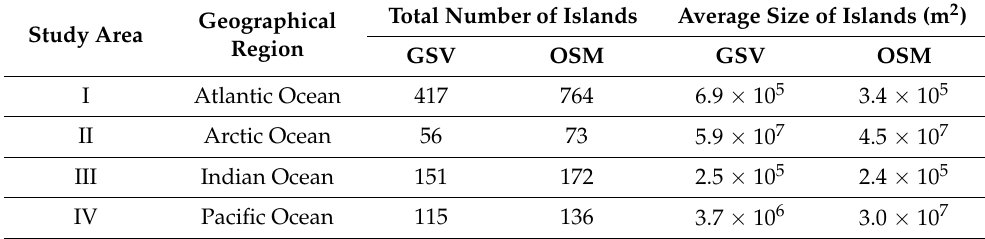
Table 1. The statistics of islands in the four study areas.